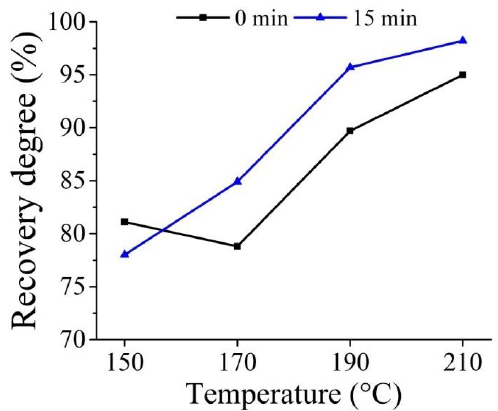
Figure 4. The effect of leaching temperature on the recovery degree of calcium without the holding (0 min) and during 15 min of high-pressure leaching of the IDBR by 10% HCl at L/S ratio = 11/1. Sodium chloride, probably formed during vacuum filtration, is also present in the samples. It should be noted a significant content of the spinel phase in all the samples due to its stability [52], as well as elemental sulfur and graphite remaining after the reduction roasting of bauxite residue. The one aluminum-containing phase is spinel. Therefore, the other aluminum phases of the IDBR sample have already been dissolved upon the heat- ing. The process of dissolution of Ti, Al, and Ca can be described as follows: 2CaO·TiO 2(s) + 8HCl (l) = 2CaCl 2(aq) + TiCl 4(aq) + TiO 2(s) + 4H 2 O (l)